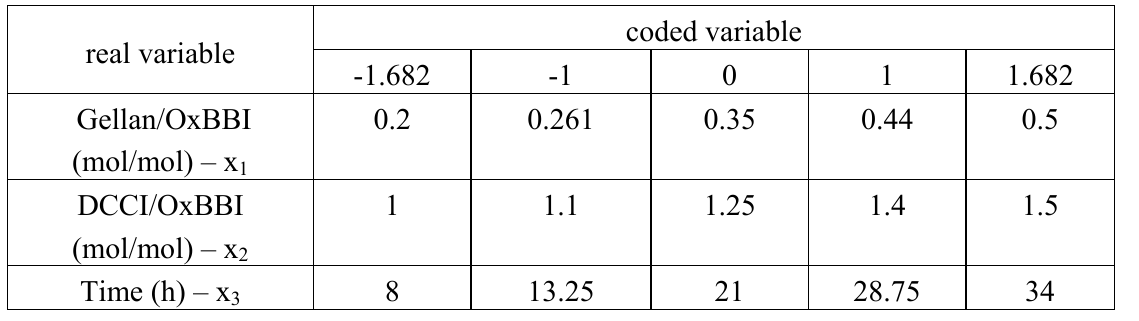
Table 2 . Codification of variables and their variation